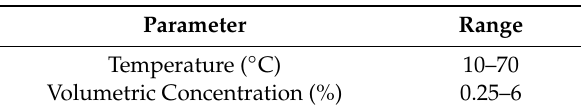
Table 1. Input parameters’ range.